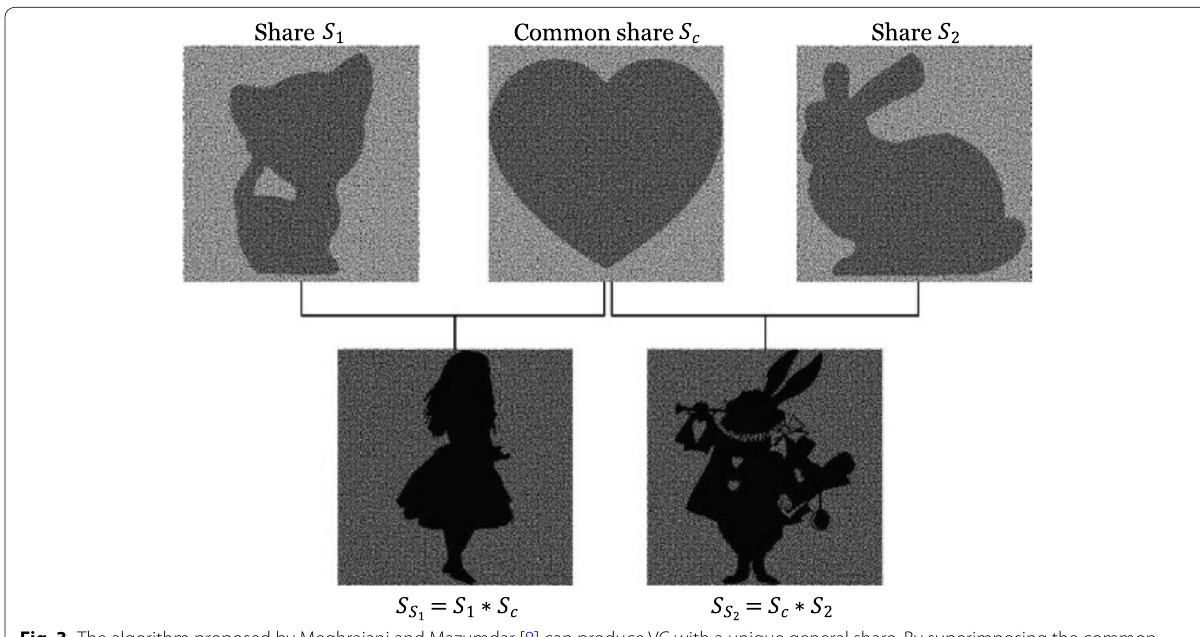
Fig. 3 The algorithm proposed by Meghrajani and Mazumdar [8] can produce VC with a unique general share. By superimposing the common share ( S c ) and other shares ( S 1 , S 2 ), the user can see different secret images ( S S 1 , S S 2 )